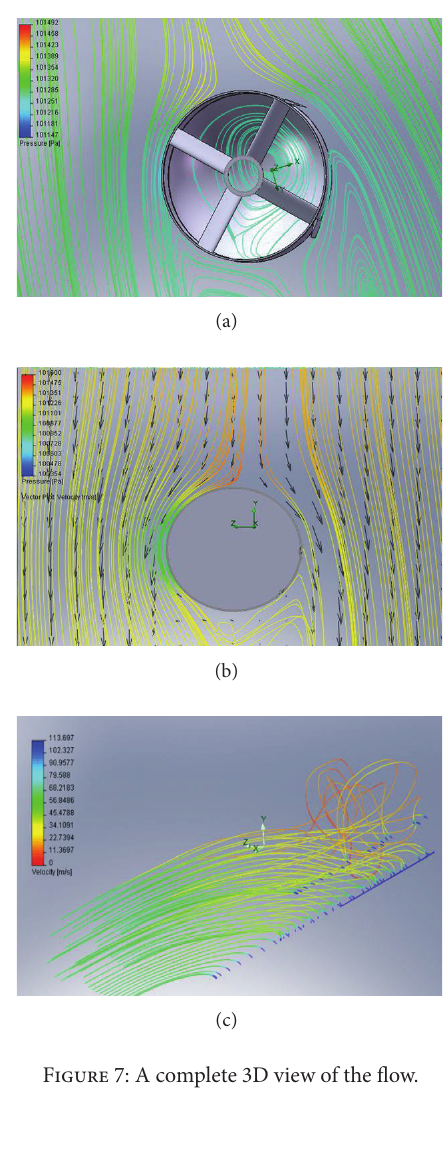
Figure 7: A complete 3D view of the flow.